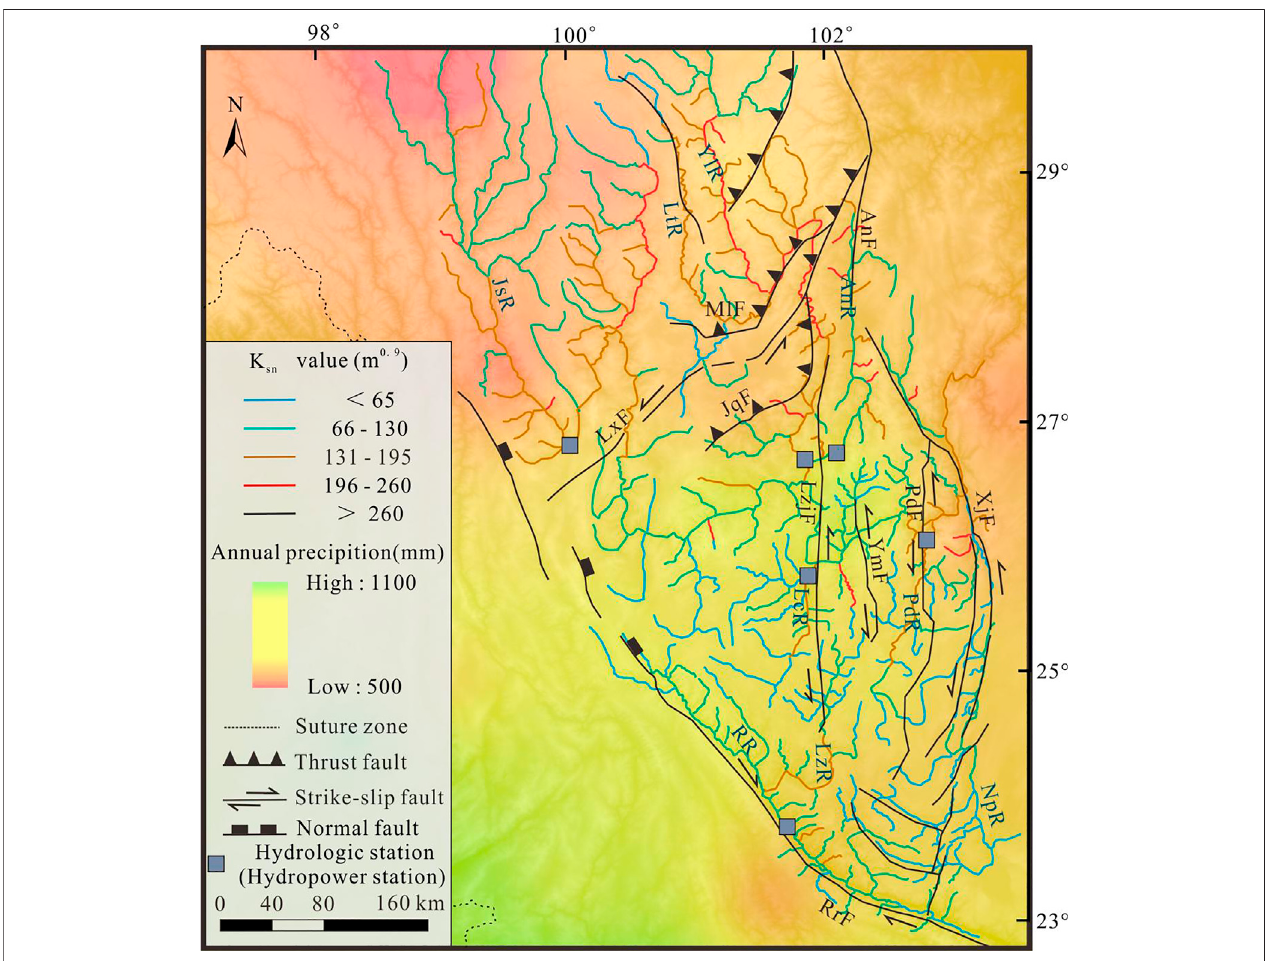
FIGURE9| Comparisonofnormalizedchannelsteepness( k sn )toannualprecipitationintheCentralYunnansubblock.Theprecipitationdata(timescale:from1970 to 2019) were downloaded from http://data.cma.cn. The tributary catchments ( white boundary ) were selected randomly for correlation analysis between channel steepness with precipitation and drainage area. AnF , Anninghe Fault; LxF , Lijiang – Xiaojinhe Fault; MlF , Muli Fault; JqF , Jinhe – Qinghe Fault; LzjF , Lvzhijiang Fault; YmF , YimenFault; PdF ,PuduFault; XjF ,XiaojiangFault; RrF ,RedRiverFault; AnR ,AnningRiver; LcR ,LongchuanRiver; PuR ,PuduRiver; LzR ,LvzhiRiver; NpR ,Nanpan River; RrR , Red River; JsR , Jinsha River; LtR , Litang River.